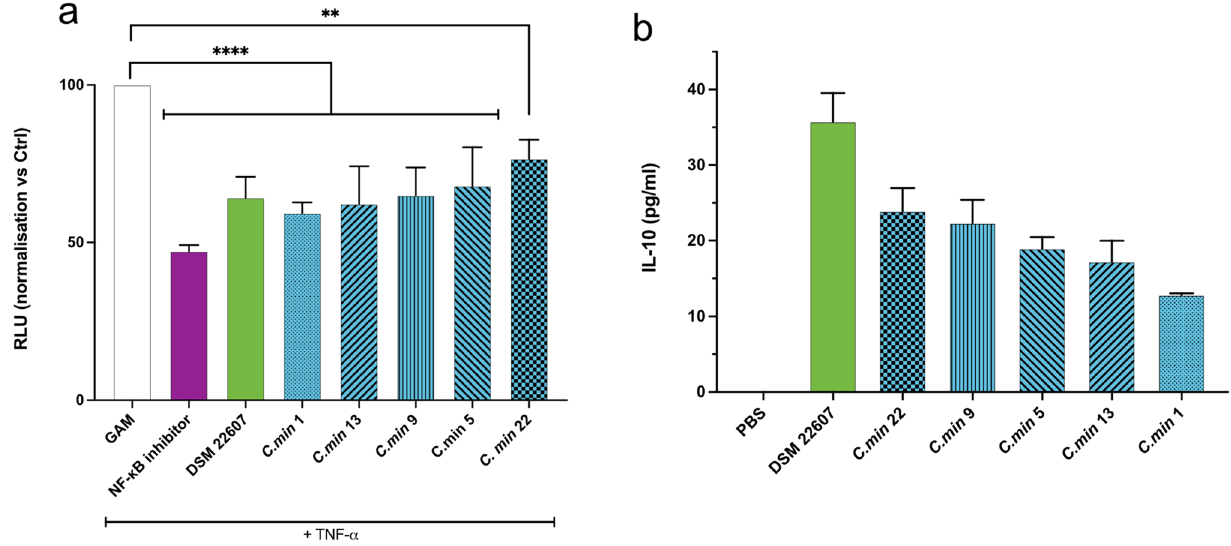
Figure 3. STEP 2 in vitro screening results confirmed the immunomodulatory action of the five pre-selected candidate strains. ( a ) Levels of NF-κB activation in HT-29 cells transfected with a reporter system and exposed to TNF-α. Statistics : one-way ANOVA followed by Dunnett’s multiple comparisons test ****p < 0.0001, **p = 0.0027 ( b ) IL-10 production by THP-1 cells differentiated in M0 macrophages by PMA treatment (100 ng/ml) in presence of C. minuta bacteria at MOI 50. No statistics were performed for this assay since any production of IL-10 was considered as a positive